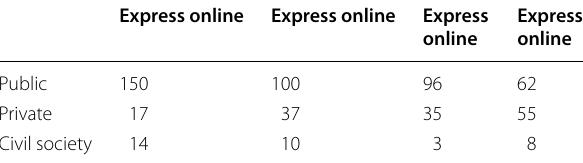
Table 3 Number of documents per group of actors